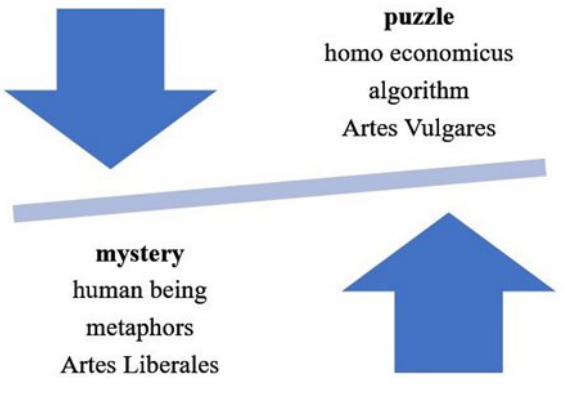
F IGURE 1. M ODEL OF MYSTERY AND PUZZLE